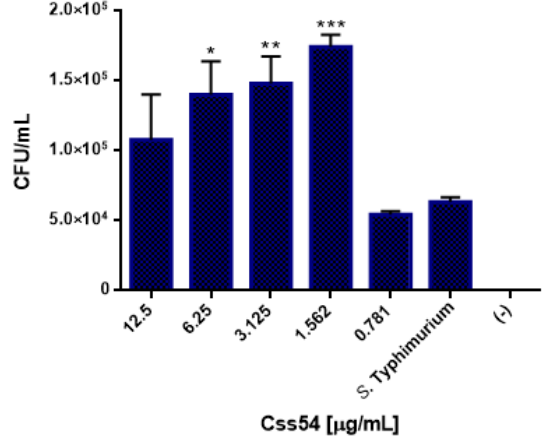
Figure 3. Css54 promotes phagocytic activity of RAW 264.7 cells. Macrophages were challenged with different concentrations of the peptide (0.78–12.5 µg/mL) for 18 h and infected with S. Typhimurium for 30 min to evaluate their phagocytic activity ( n = 3). S. Typhimurium: infected cells without peptide; Control ( − ): cells without bacteria. Figure shows the average of three independent experiments (* p < 0.05; ** p < 0.01; *** p < 0.001) .